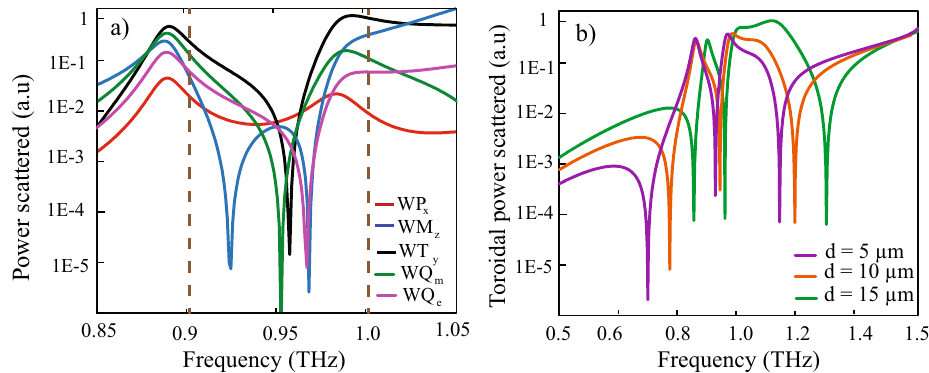
Figure 4. ( a ) Multipolar analysis for the MM configuration over the simulated frequency range indicating a dominance by toroidal dipolar excitation over electric and magnetic dipolar contributions, as well as electric and magnetic quadrupolar contributions. Dotted brown lines indicate positions of peak 1 and peak 2, respectively. ( b ) Blue shift in in the toroidal scattered power on increasing the distance ‘ d ’ between the mid SRR and the C shaped resonators on both sides.